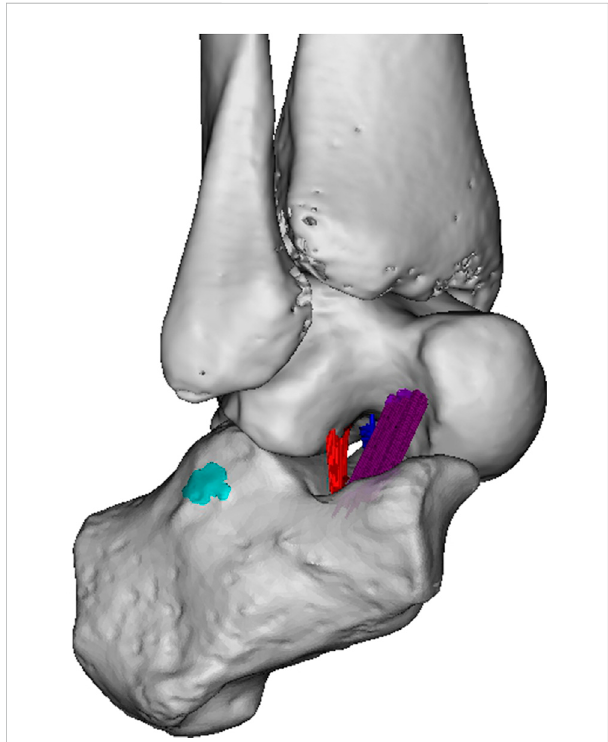
FIGURE 1 Subtalar ligaments. Sinus tarsi view. The following structures are indicated in colour: ITCL fi bers (dark blue), CL fi bers (purple), ACaL fi bers (red) and CFL footprint (cyan blue). (Figure 2G in Foot and Ankle Surg 2021 January; 27 (1):101 – 109, no permission